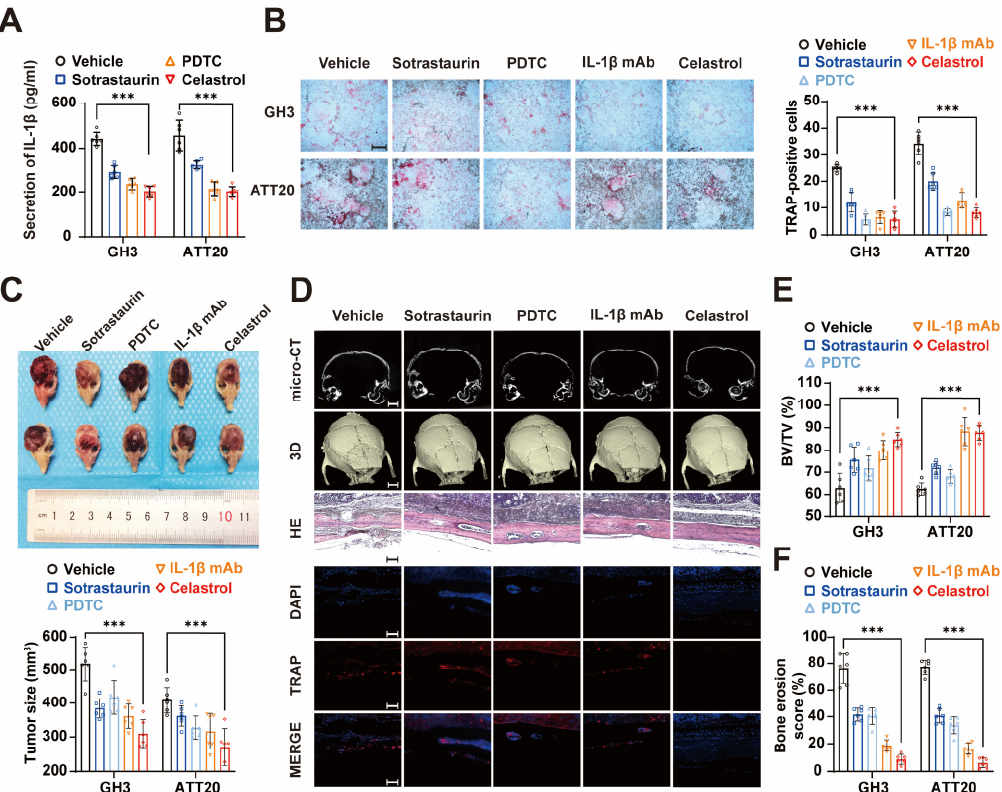
Figure 6. The role of celastrol in reducing bone invasion in PAs. ( A ) ELISA to detect the secretion level of IL-1β levels of GH3 and ATT20 in treatment with sotrastaurin, PDTC, and celastrol ( n = 6 independent experiments). ( B ) TRAP staining of RAW264.7 were cocultured with GH3 or ATT20 while in treatment with sotrastaurin, PDTC, IL-1β mAb, and celastrol (×40; scale bar, 500 µm). Quan- tification, right ( n = 6 independent experiments; *** p < 0.001). ( C ) Photographs of GH3 calvaria xen- ograft tumor specimens in treatment with sotrastaurin, PDTC, IL-1β mAb, and Celastrol. Quantifi- cation of tumor size, bottom ( n = 6 mice per group; *** p < 0.001; NS p ≥ 0.05). ( D – F ) Micro-CT, 3D- reconstruction, HE staining, and immunofluorescence of TRAP+ cells in the tumor–bone junction area ( D ) (×200; scale bar, 100 µm). Quantification of bone volume/tissue volume (BV/TV) ( E ) and bone erosion score ( F ) ( n = 6 mice per group; *** p < 0.001).